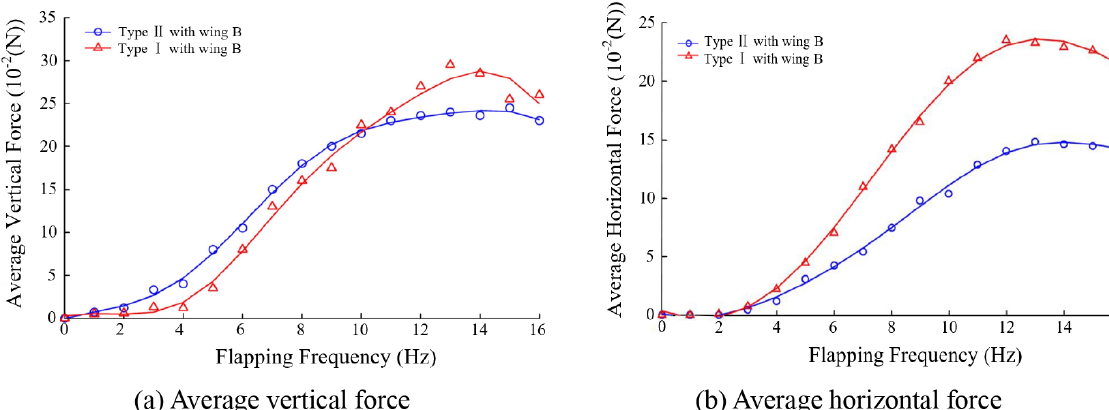
Figure 11. Comparison tests of different